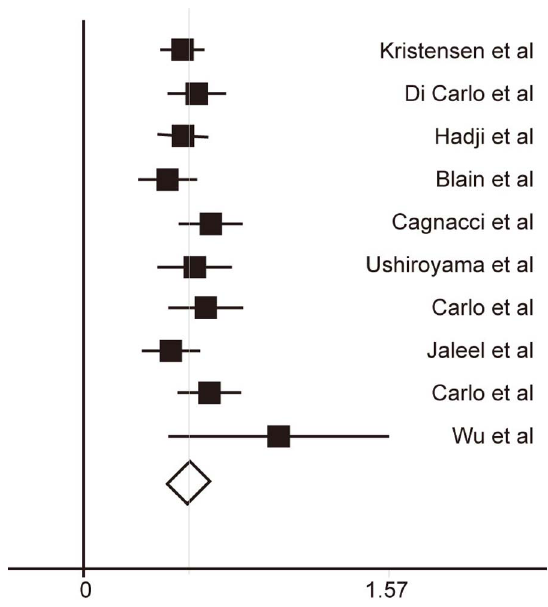
Figure 2. Forest plot indicating the r between LC and body mass index (BMI) of postmenopausal women (PW). Horizontal lines denote 95% confidence interval (CIs); the diamond indicates the combined r with the corresponding 95% CI.